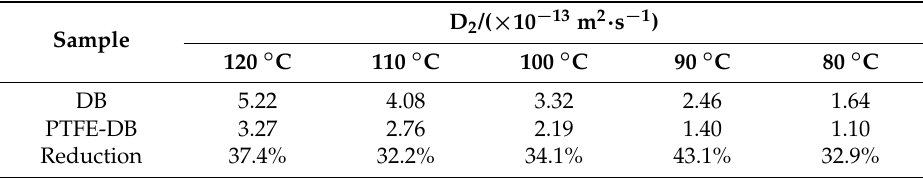
Table 5. Diffusion kinetics of NG calculated from later stage evaporation in the two propellants.